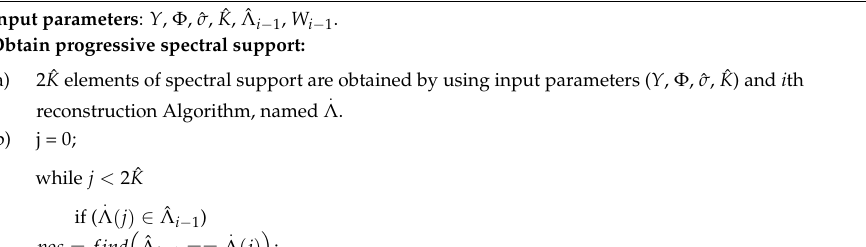
Algorithm 2. The i th support reconstruction with the progressive